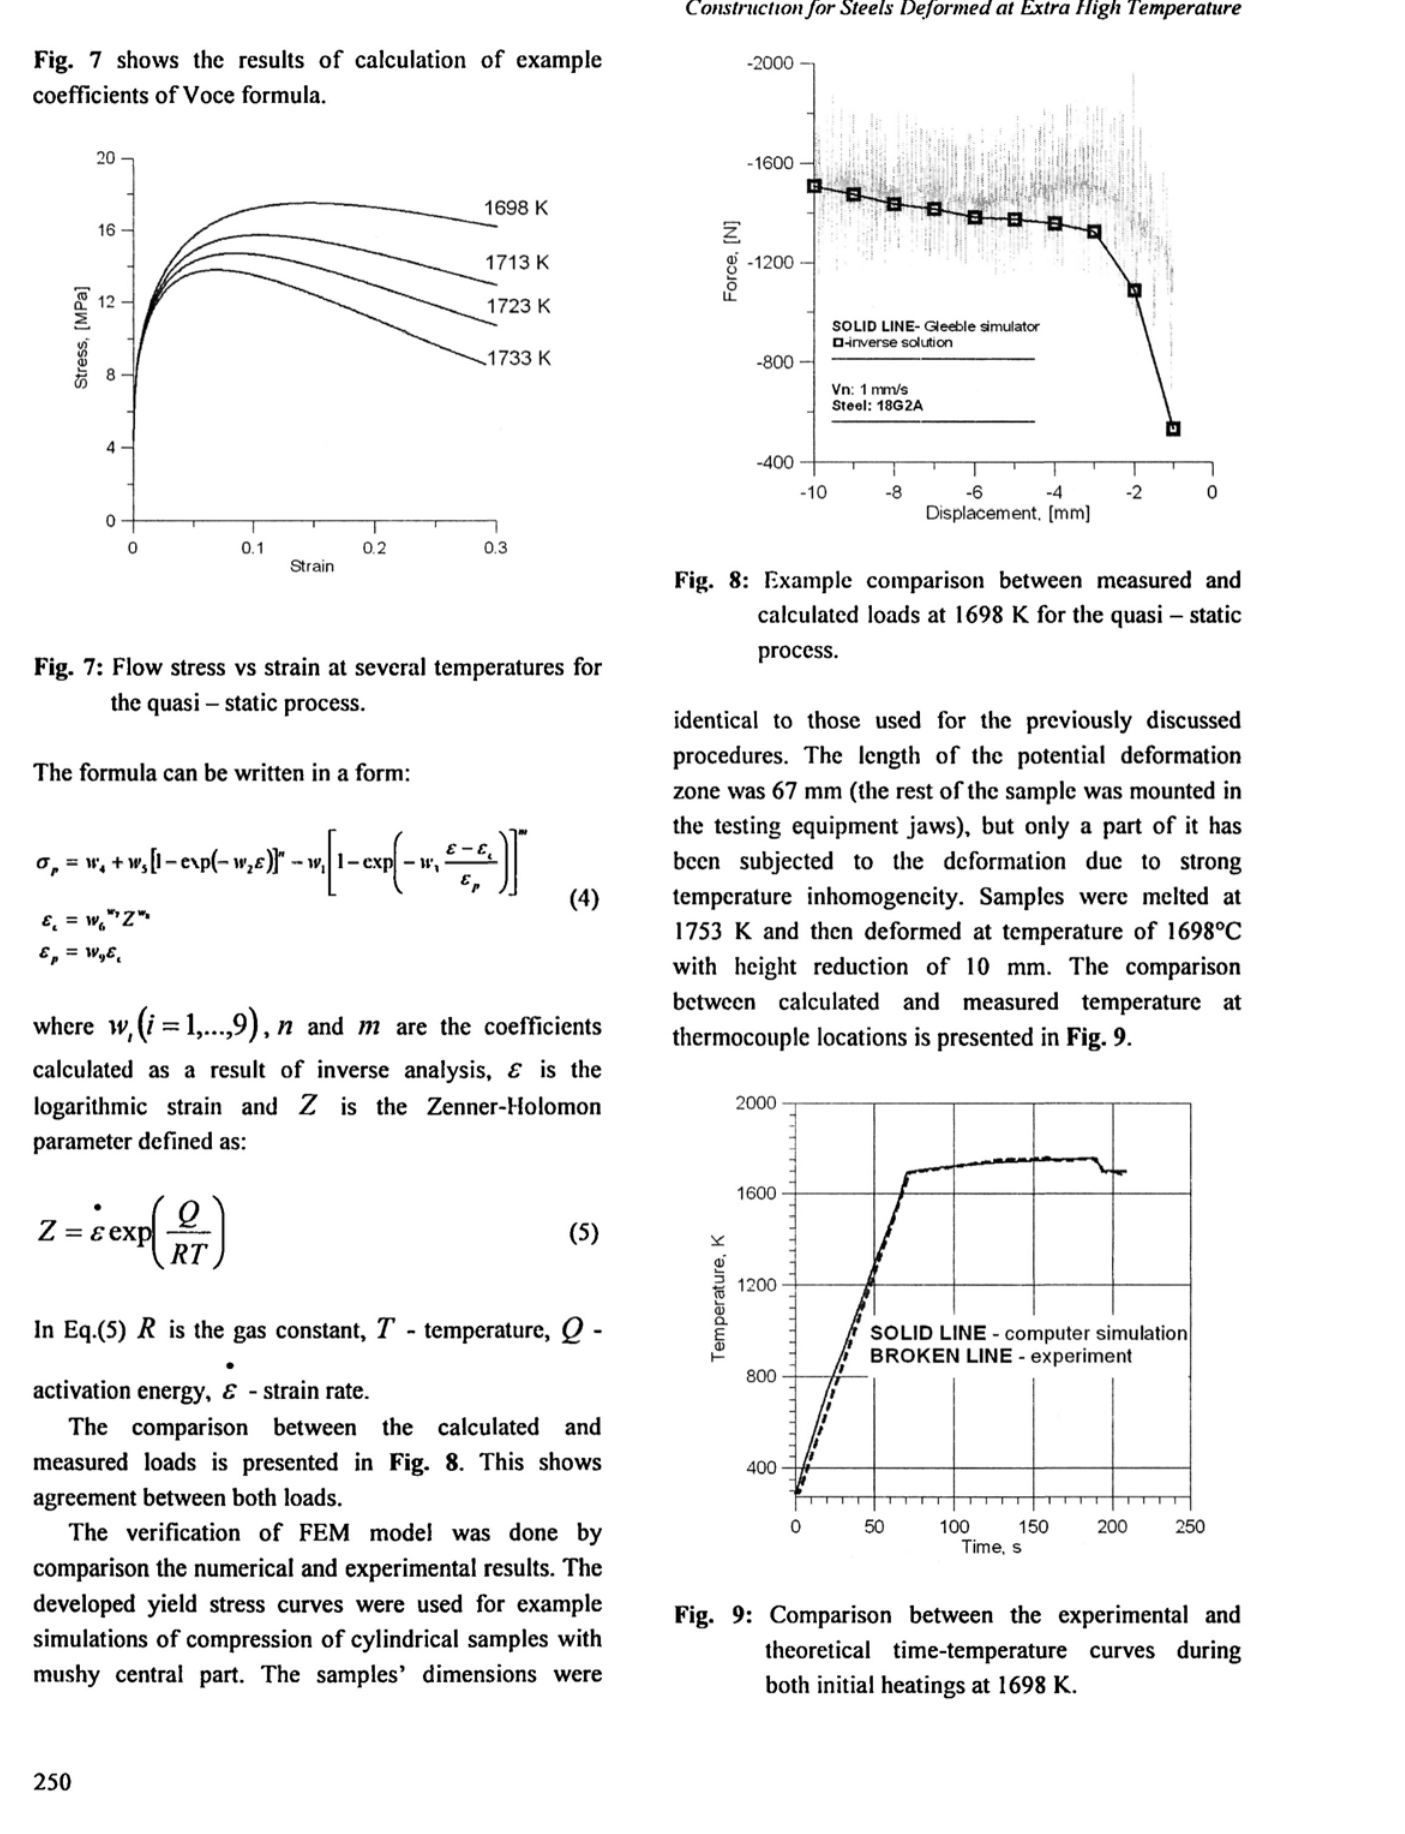
Fig. 8: Example comparison between measured and calculated loads at 1698 Κ for the quasi - static process.